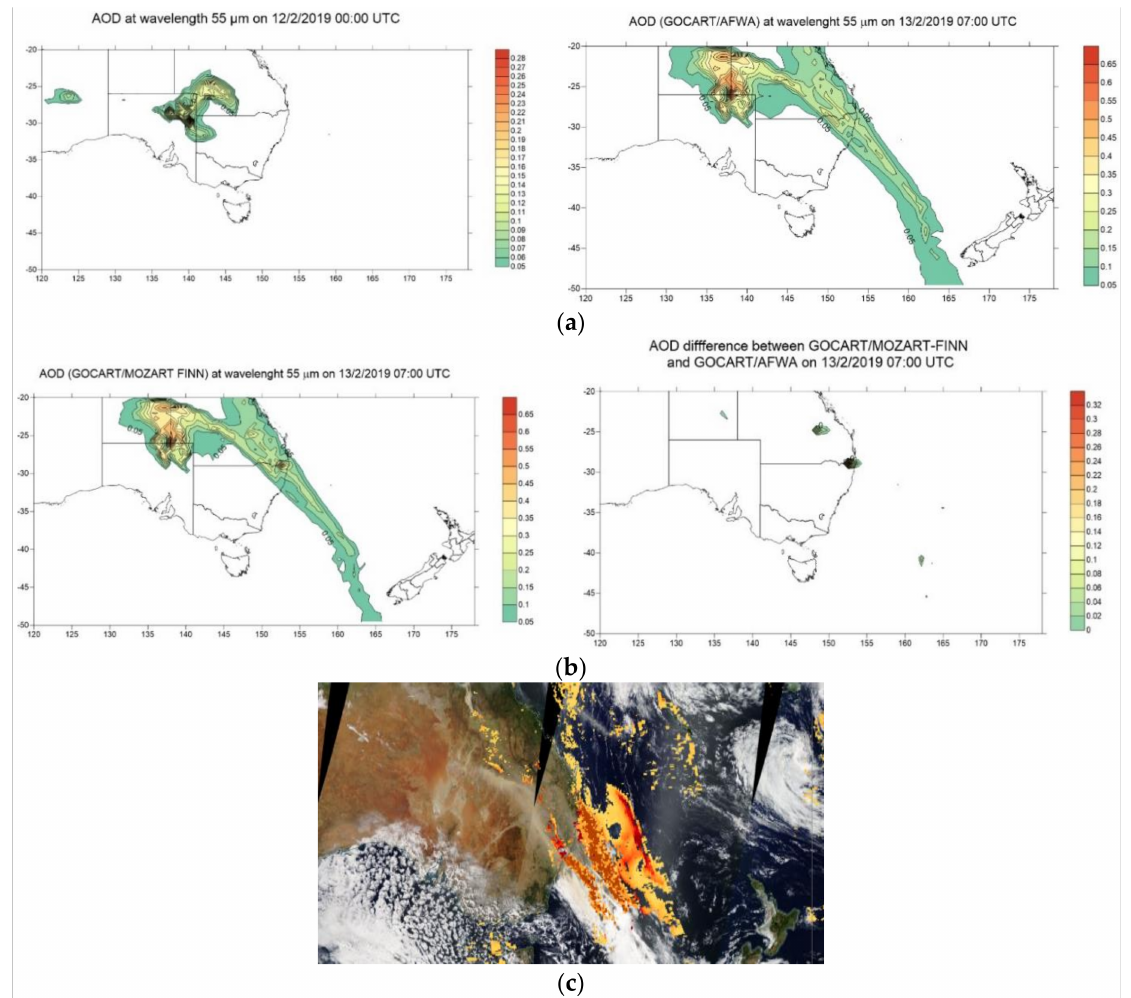
Figure 6. ( a ) Predicted AOD on 12 February 2019 at 00:00 UTC and 13 February 2019 at 07:00 UTC with GOCART aerosol chemistry + AFWA dust scheme. ( b ) Predicted AOD 13 February 2019 at 07:00 with GOCART/AFWA/MOZART and FINN model and difference in predicted AOD from WRF-Chem without wildfires (GOCART/AFWA) and with wildfires (GOCART/AFWA/MOZART FINN). ( c ) AOD derived from MODIS Aqua/Terra satellite observation (3 km land and ocean) on 13 February 2019 3:50 UTC (Aqua) and 12 February 2019 23:30 UTC